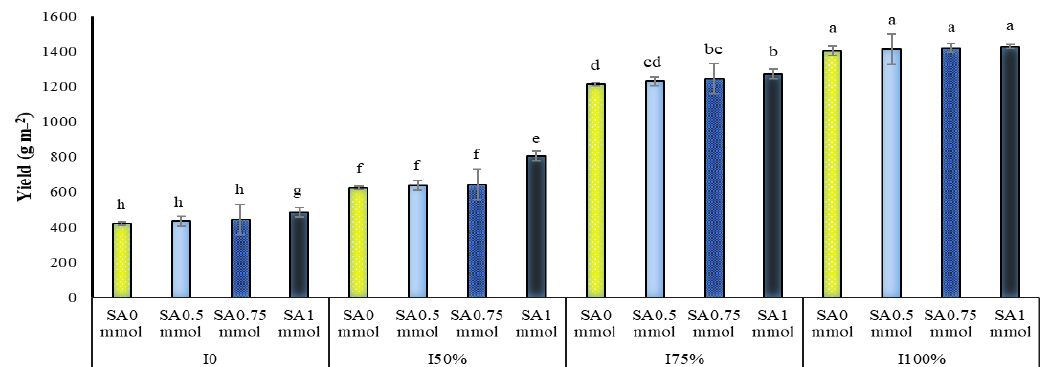
Figure 6. Dual interaction of different levels of irrigation (I0 = no irrigation, I50% = 50%, I75% = 75%, and I100% = 100% water requirement of the plant) and salicylic acid application concentra- tions (SA0 = non-application, SA0.5 = 0.5 mmol, SA0.75 = 0.75 mmol and SA1 = 1 mmol) on A. hirti- folium onion yield. Columns designated by the same letter are not significantly different at the p ≤ 0.05 level as determined by the LSD test.